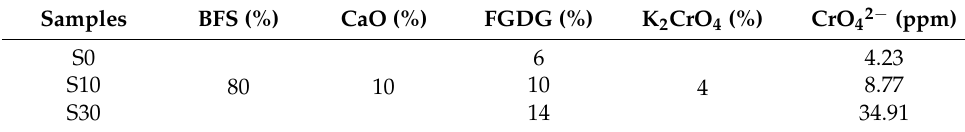
Table 5. Leaching concentration of CrO 42 − at different levels of FGDG doping.